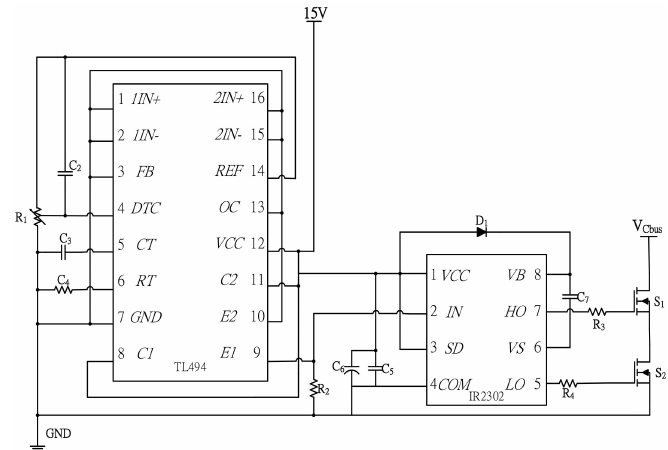
Figure 5. Control